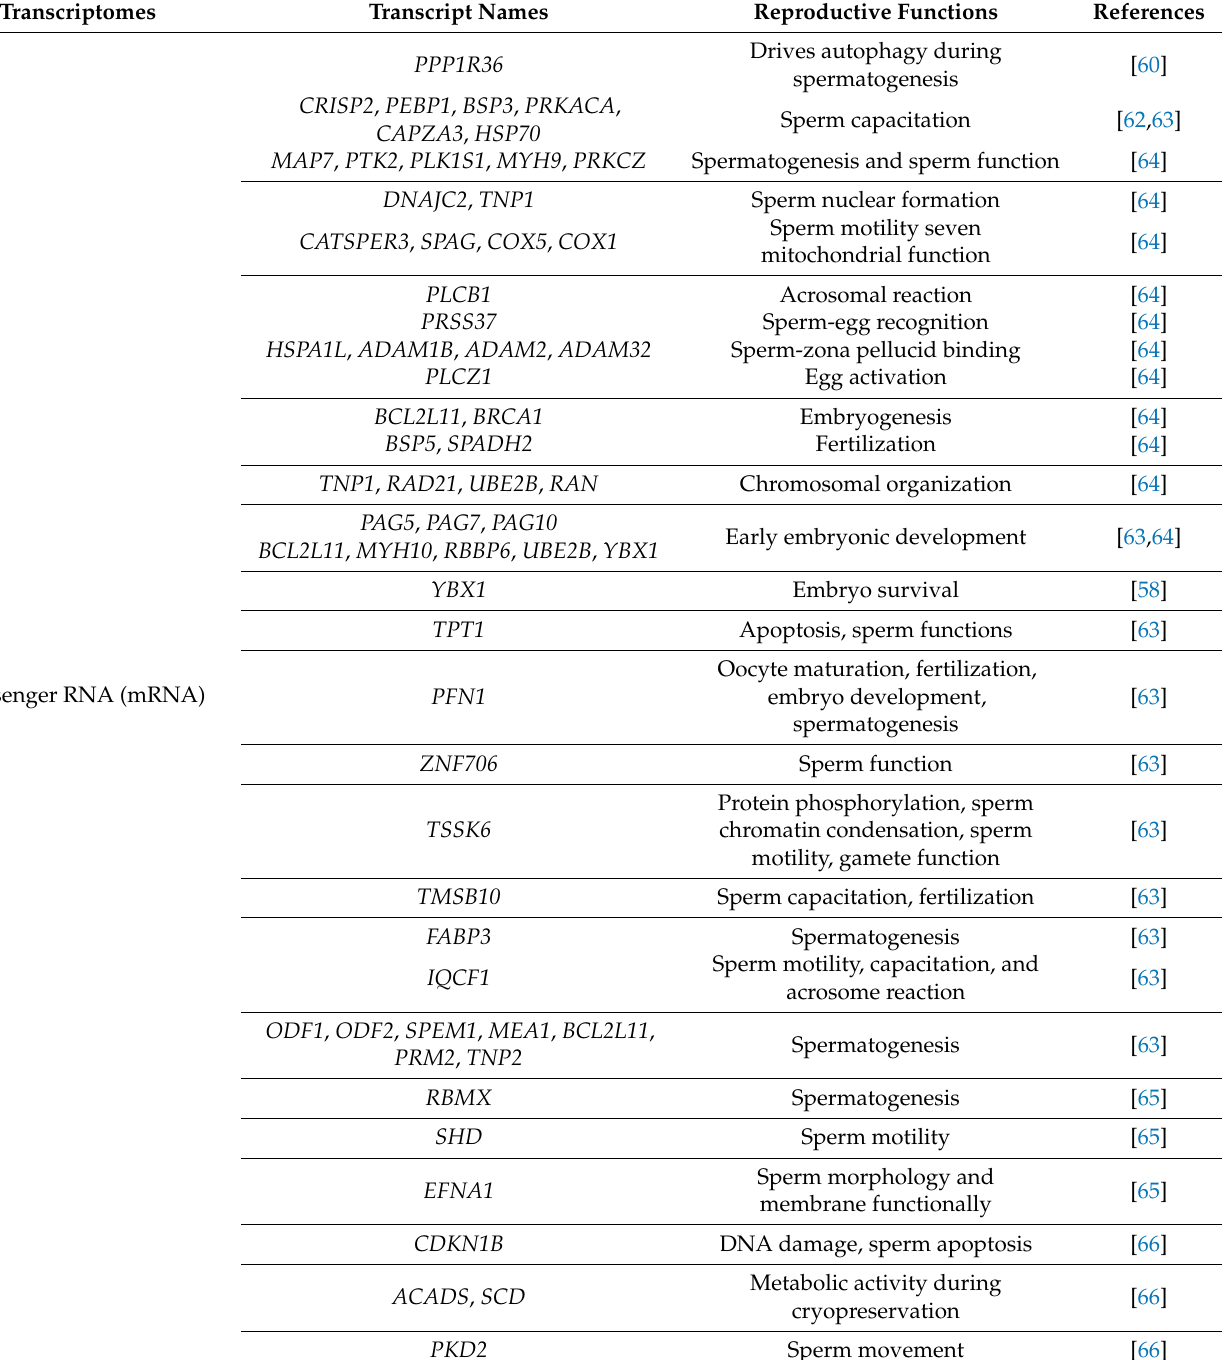
Table 1. The list of sperm transcriptomes and their functions in reproductive